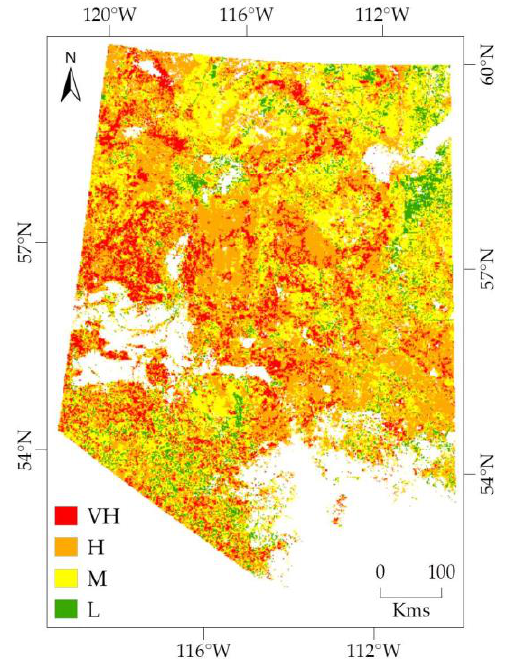
Figure 7. An FFD map was generated using NRT swath data of Ts variable that was derived by applying our proposed algorithm, and NRT gridded data for calculating NDVI and NDWI variables.